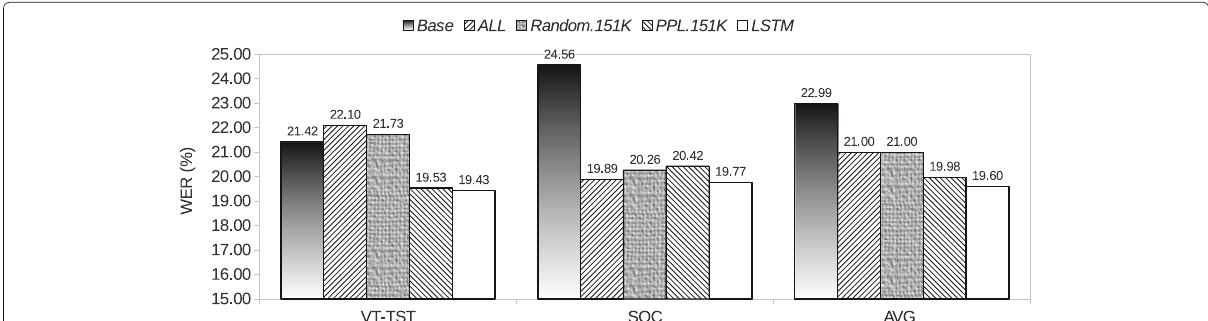
Fig. 6 Recognition performance (WER) using 151K selected